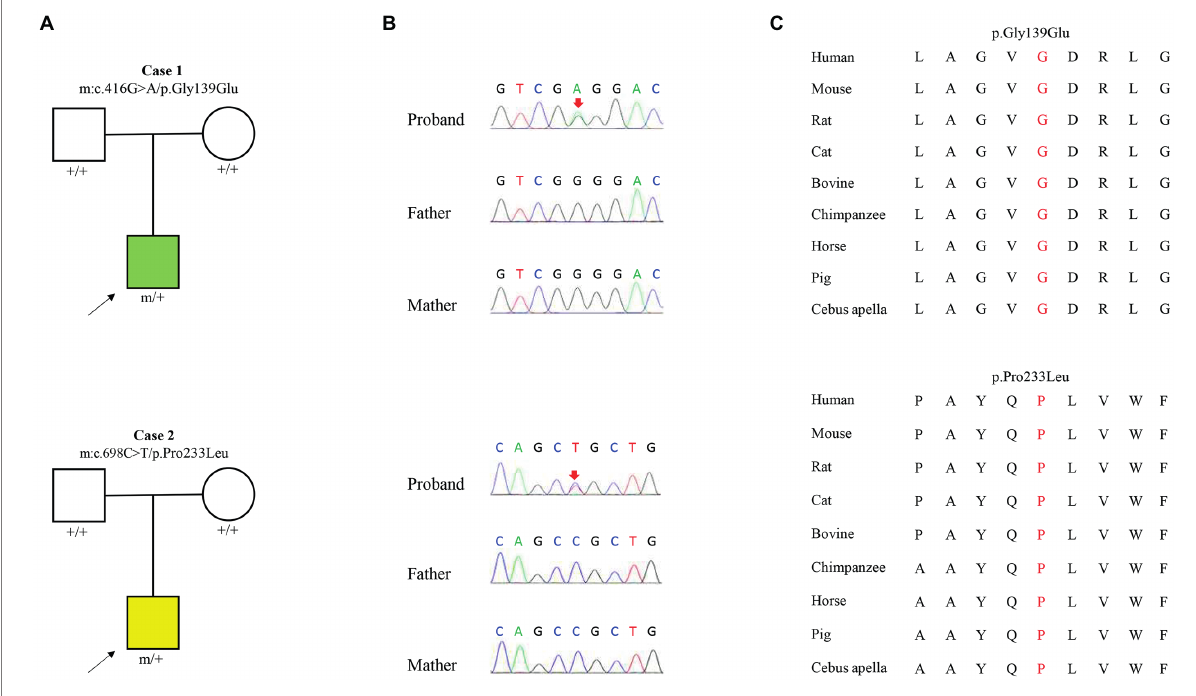
FIGURE 1 Genetic data of cases with KCNK4 variants. (A) Pedigrees of the two cases with KCNK4 variants. (B) DNA sequence chromatogram of the KCNK4 variants. Arrows indicate the positions of the mutations. (C) The amino acid sequence alignment of the six missense mutations shows that the two variants are highly conserved across